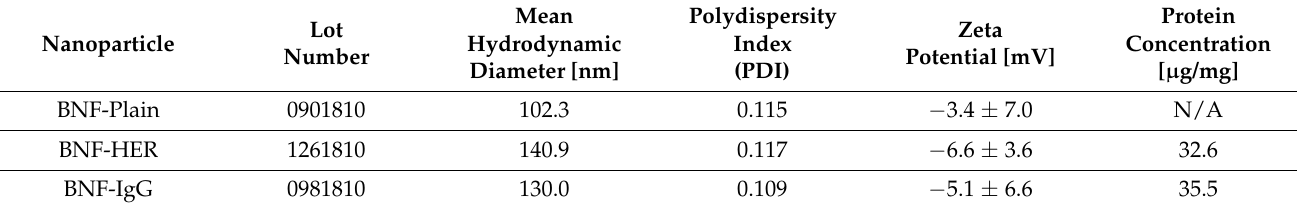
Table 5. Physical characteristics of the